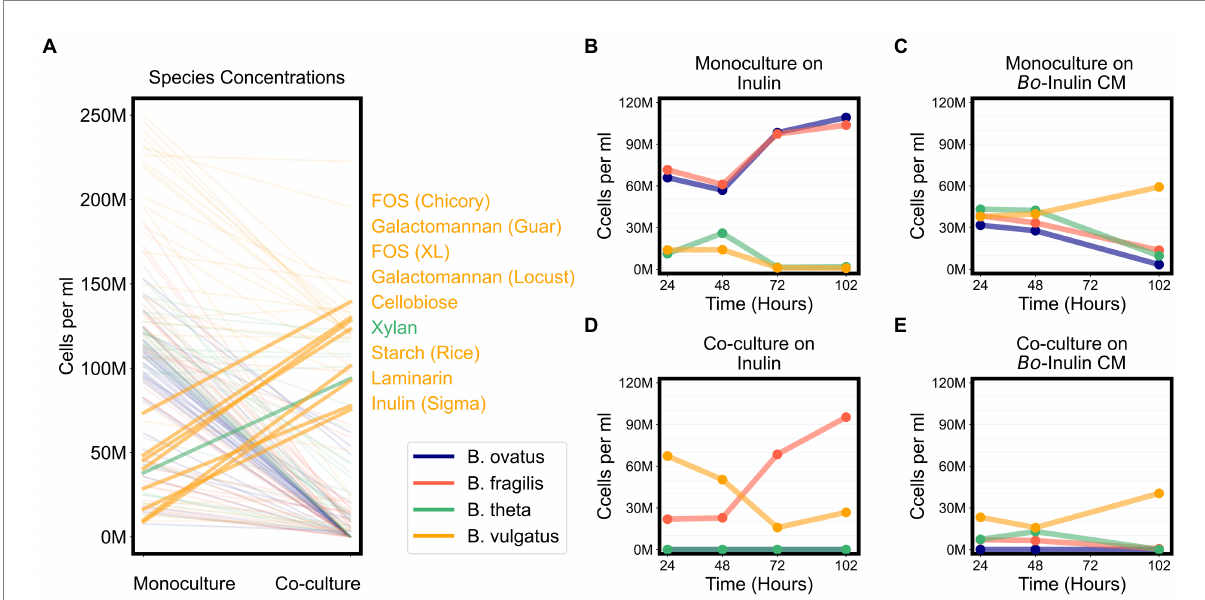
FIGURE 6 Bacteroides vulgatus is the primary beneficiary of cross feeding on complex sugars. (A) Lines plot the differences in the maximum abundances (cells per ml) of each of the Bacteroides species on each substrate in monocultures vs. co-cultures. Species abundances in co-cultures that are at least 20% higher than their corresponding abundances in monocultures are highlighted with thicker lines and annotated on the right side of the plot. Substrate annotations are ordered by abundance values in co-cultures. (B,D) Abundances in monocultures and co-cultures on minimal media supplemented with inulin. (C,E) Abundances in monocultures and co-cultures on minimal media supplemented with conditioned media (CM) from the growth of Bacteroides ovatus on inulin. In all plots, “M” indicates values in the